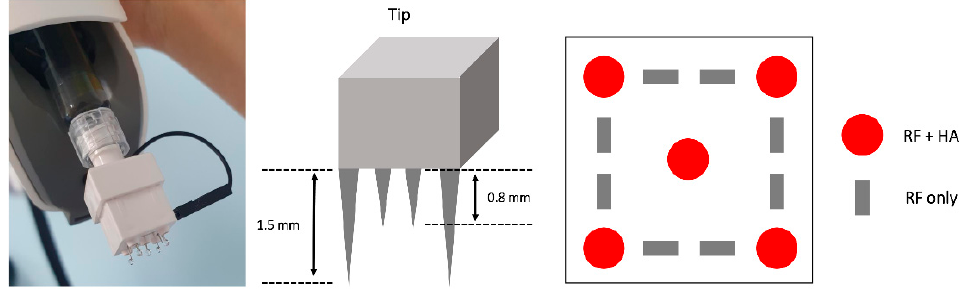
Figure 1. The radiofrequency hydro-injector device consists of five microneedles (34-gauge needle; injection depth, 1.5 mm) delivering both hyaluronic acid filler (HA) and radiofrequency (RF) energy to the deep dermis, and eight microneedles (depth, 0.8mm) delivering RF energy to the superficial dermis.